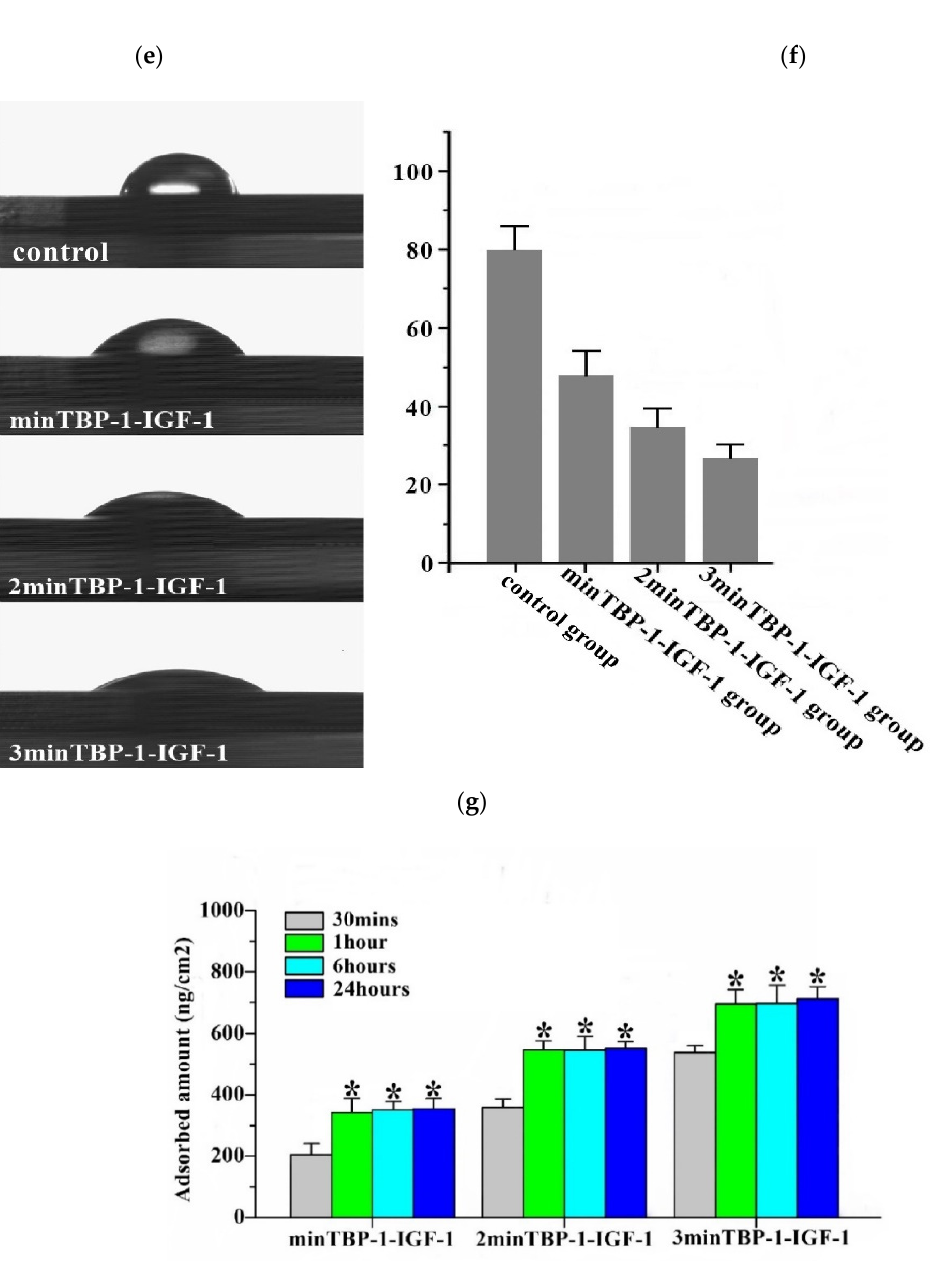
Figure 2. Surface characteristics of each group and adsorption capacity of the modified protein. ( a – d ) AFM images of machined surface and (n)minTBP-1-IGF-1-Ti biointerfaces. ( e , f ) Water contact angle of the interfaces. ( g ) The amounts of modified IGF-1s adsorbed on Ti surfaces. n = 10, * p < 0.05. The interface wettability was characterized by the water contact angle